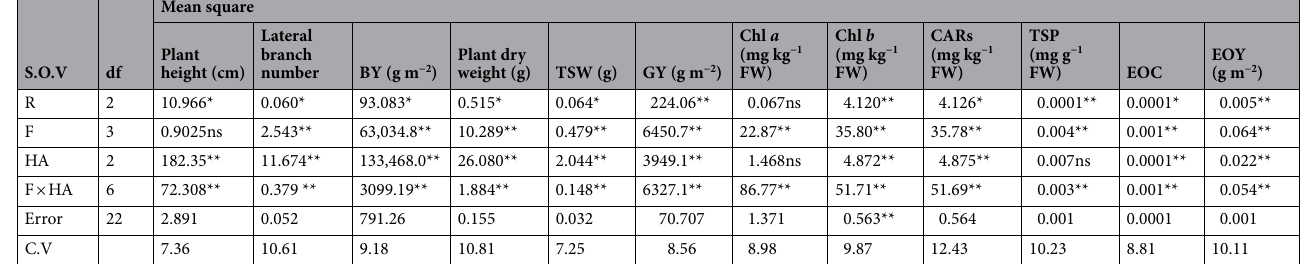
Table 1. Variance analysis for the growth traits, minerals content and essential oil content and yield of coriander plants in response to the chemical and organic fertilizers as well as humic acid application. *, ** and ns, significant at the 5% and 1% probability levels and non-significant,